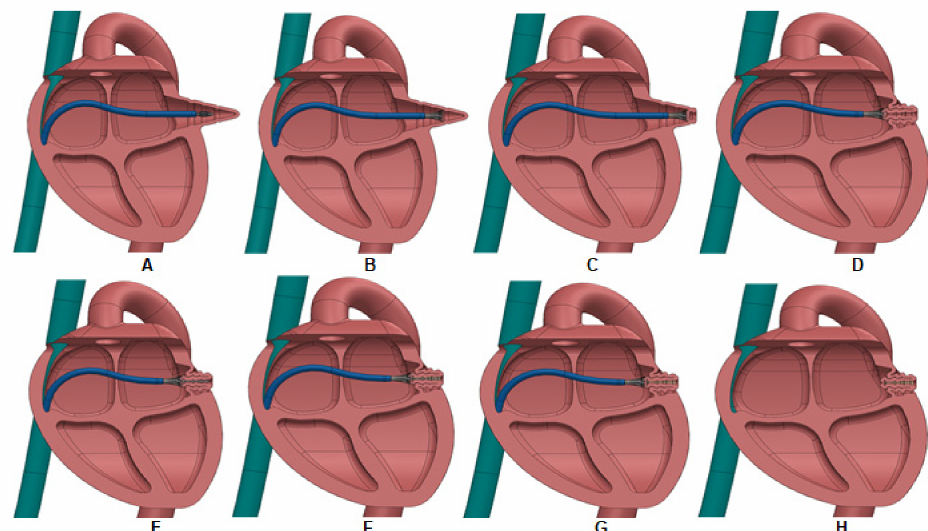
Figure 1. Schematic of LAA closure device and approach. The progression of the procedure is from ( A – H ). ( A ): Insert device into the LAA. ( B ): Deploy suction flute. ( C ): Suction onto inside distal wall of the LAA. ( D ): Pull the LAA inward and invert it. ( E ): Extend needle into inverted space. ( F ) Inject adhesive through needle-tip hypo-tube wire with side holes (blind closed tip). ( G ): Retract needle and maintain suction until adhesive cures. ( H ): Remove closure device leaving only tissue glue behind. The inversion of the LAA apex is not to scale, and can be much less, depending on the length of the